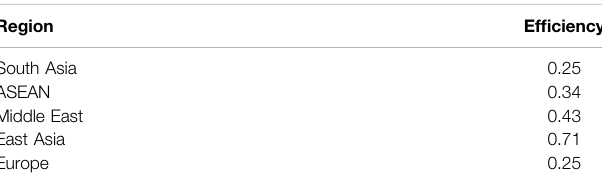
TABLE 3 | Regional ef fi ciency score.